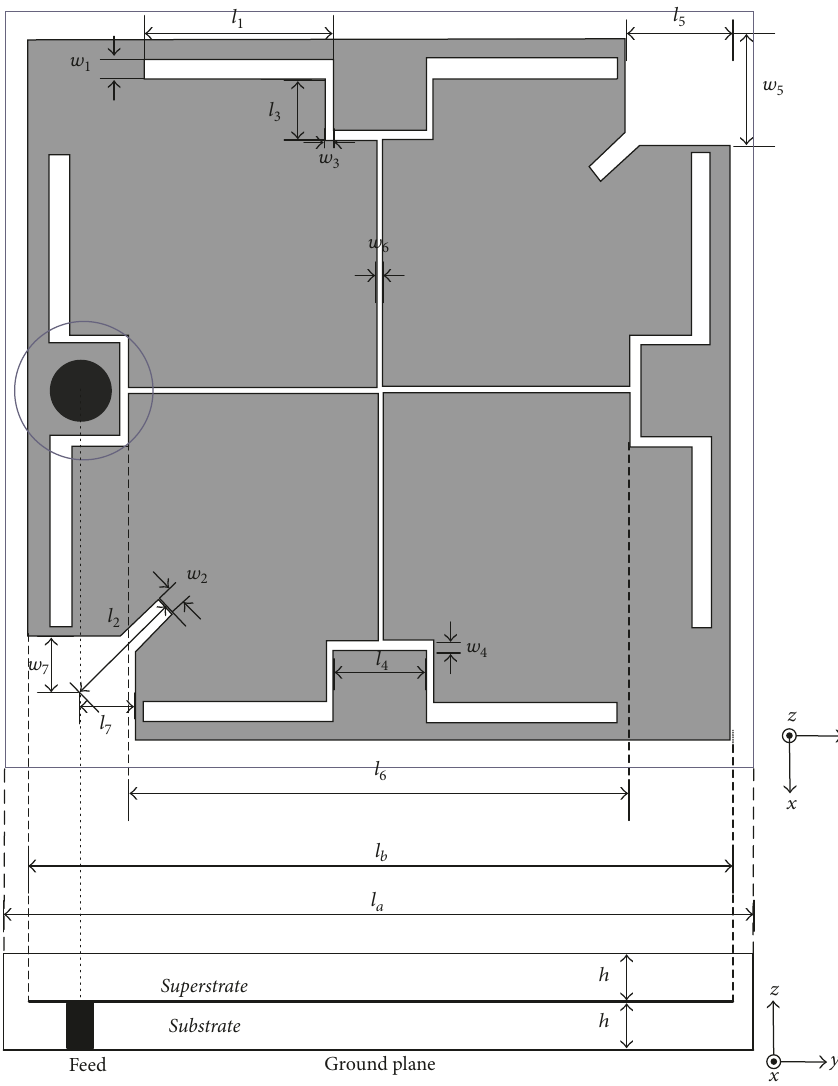
Figure 1: Geometry of the proposed circularly polarized